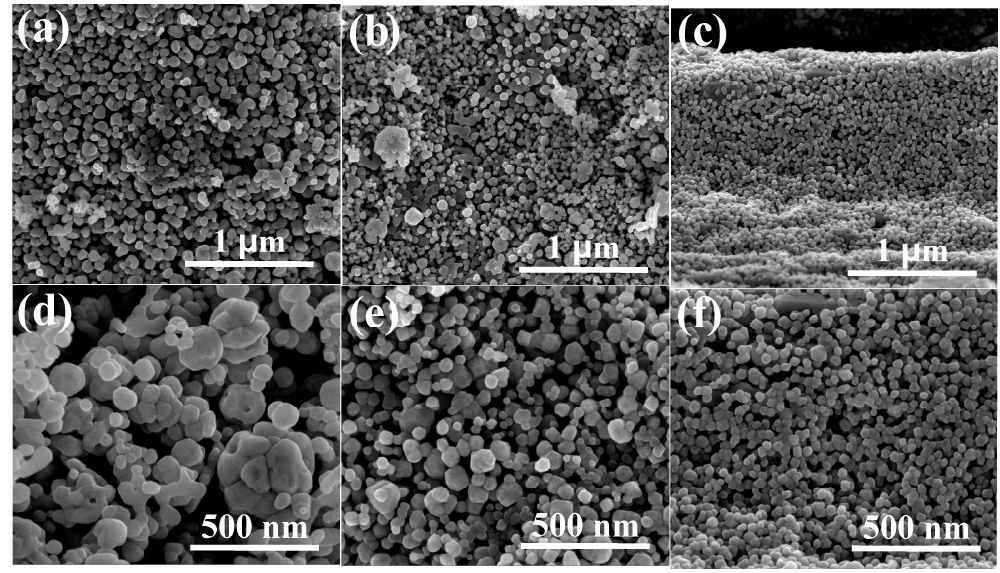
Figure 2. SEM images of ZnCo 2 O 4 nanoparticles: ( a , d ) sample A; ( b , e ) sample B; and ( c , f ) sample C.